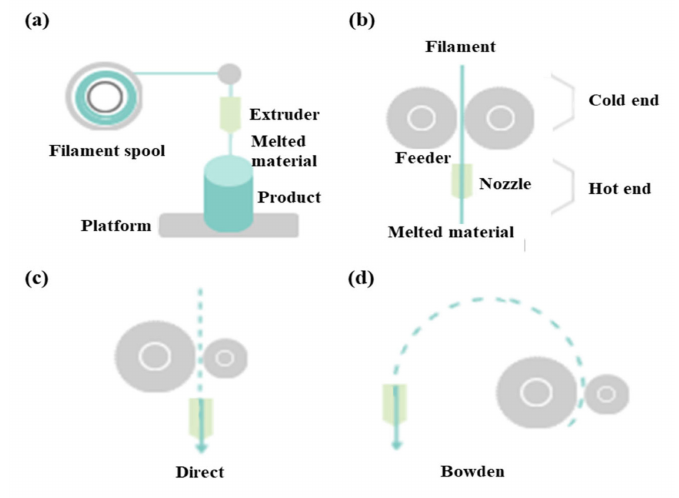
Figure 2. Di ff erences between direct extruder and Bowden extruder in fused deposition modeling: ( a ) printing filament through an extruder, ( b ) distinction between cold and hot ends, ( c ) direct extruder, ( d ) Bowden extruder three-dimensional printers classified according to type and